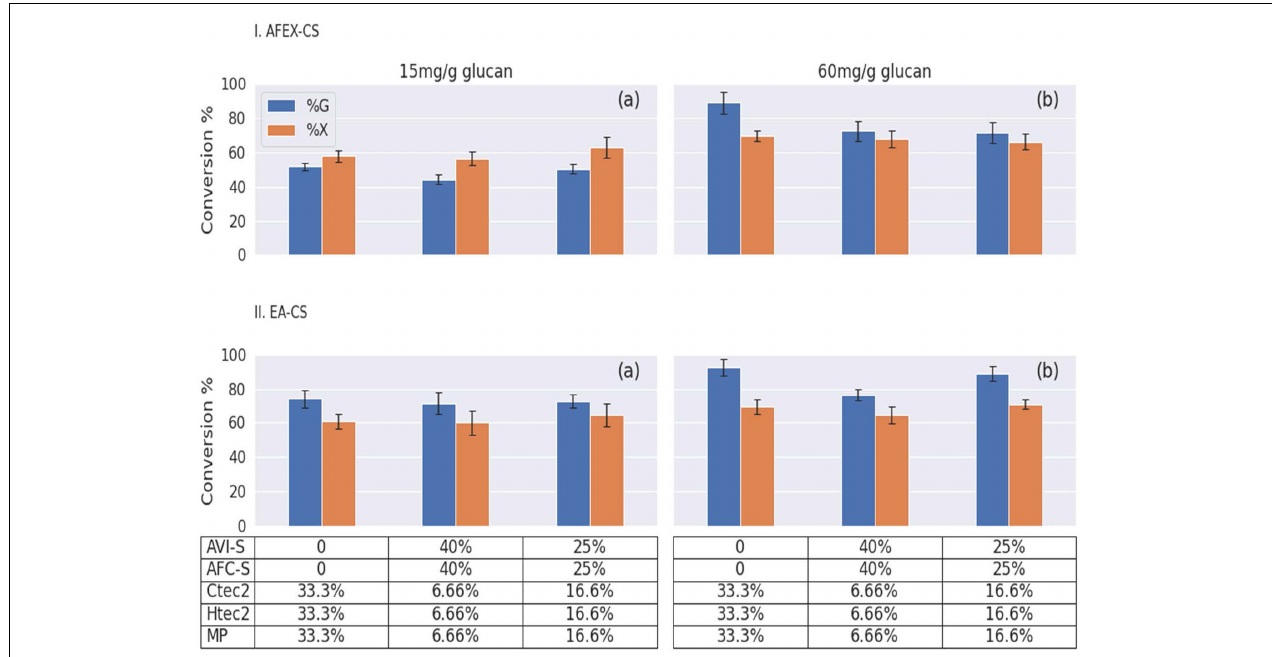
FIGURE 7 | Bar graphs showing the percentage of glucan (G) and xylan (X) conversions for different pretreated corn stover after 24 h hydrolysis. Here, (I) AFEX-CS and (II) EA-CS were used as substrates. An equal amount of Geobacillus sp. WSUCF1 bacterial strain secretomes (AVI-S and AFC-S) and commercial enzymes (Ctec2, Htec2, and MP) at two enzymes loading [(a) 15 mg/g or (b) 60 mg/g of glucan] at two ratios (50:50 or 80:20). The x-axis on the graphs shows the percent of glucan/xylan conversion and y-axis show the different combinations of secretome produced using substrates given in the bracket. Here, AVI-S (Avicel), AFC-S (AFEX-CS); commercial enzymes (Ctec2, Htec2, and MP). On the y-axis the table shows the percentage of each enzyme mixture